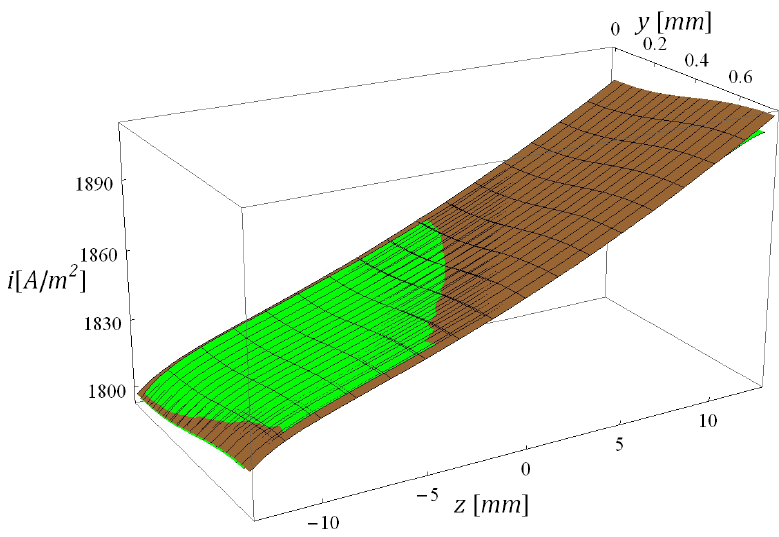
Figure 7. Best fit of results on current density distribution at 0.85 V of operational voltage. Green are CFD results and brown HAN 6